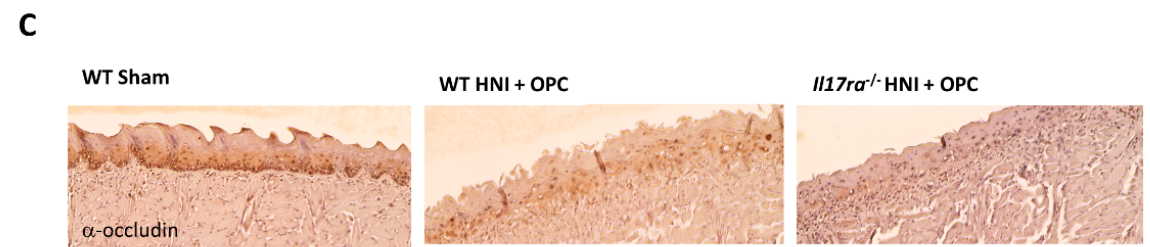
Figure 4. IL-17RA is required to prevent dissemination of C. albicans across the radiation-damaged oral mucosa. ( A ) WT and ll17ra − / − (n = 3 or more mice per group) mice were subjected to HNI and 12–16 h later were infected sublingually with C. albicans . On Day 4 both kidneys were harvested, homogenized, and plated in triplicate. CFU/g of kidney tissue was determined. Analyzed by Mann– Whitney U test. Data shown as geometric mean. ( B ) On Day 4 both stomach and intestines were harvested, homogenized, and plated in duplicate. CFU/g of stomach and intestine tissue was deter- mined (n= 3–6 mice per group). Analyzed by one-way Anova with Tukey’s post hoc. ( C ) Repre- sentative Occludin-staining of ulcer boundary region counterstained with hematoxylin . Images taken at 10x magnification. Images representative of 3 mice per group and 2 experimental repeats. (* p < 0.05, ** p < 0.01).